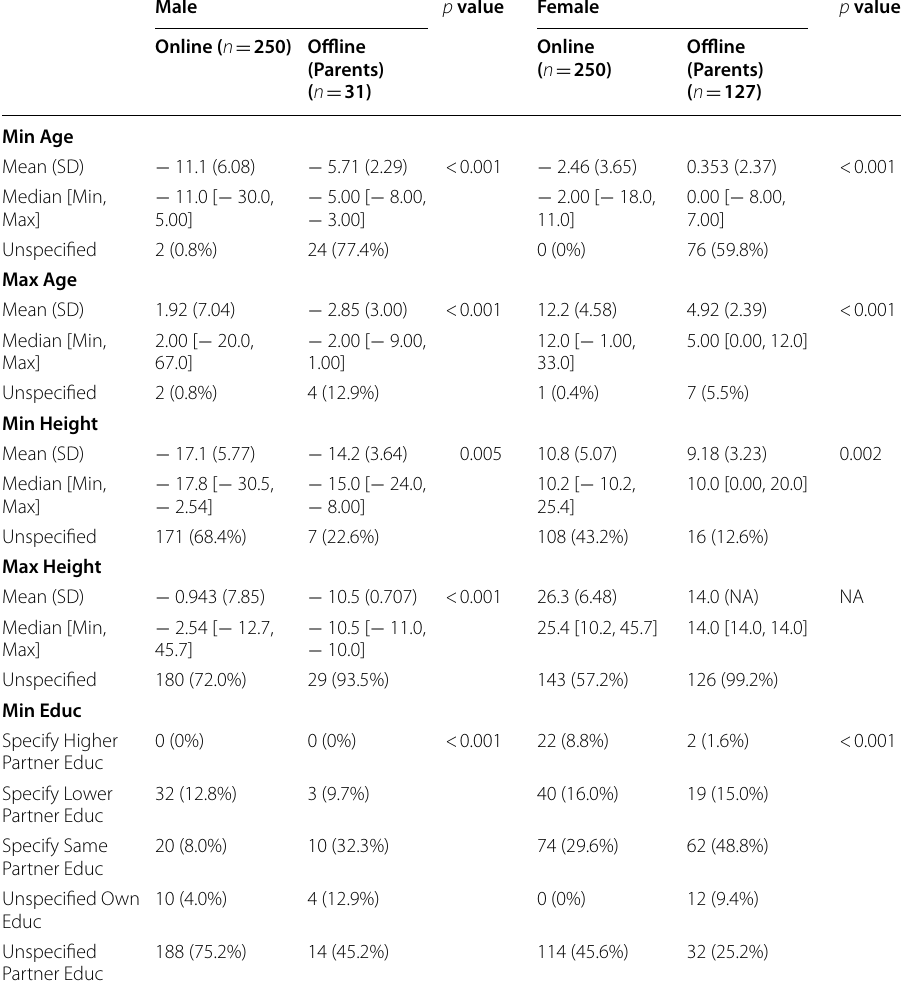
Table 3 Desired Partner Attributes between the online and offline sample, within each gender Male p value